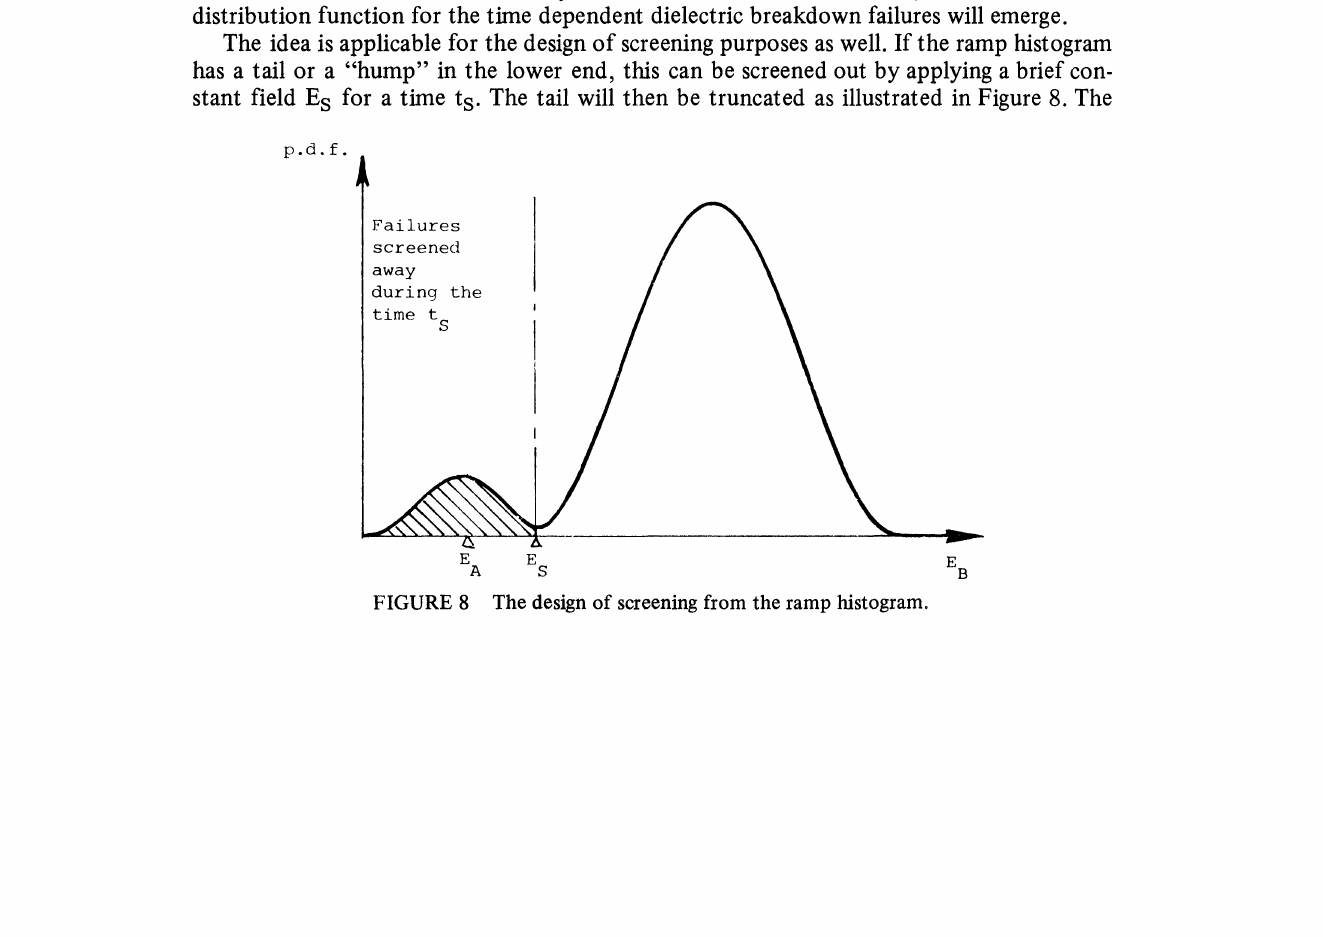
FIGURE 8 The design of screening from the ramp